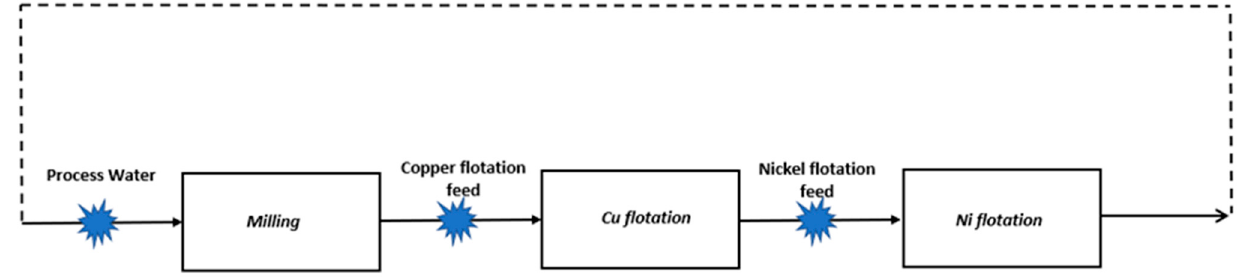
Figure 2. Sampling scheme for the Kevitsa plant sampling campaign.